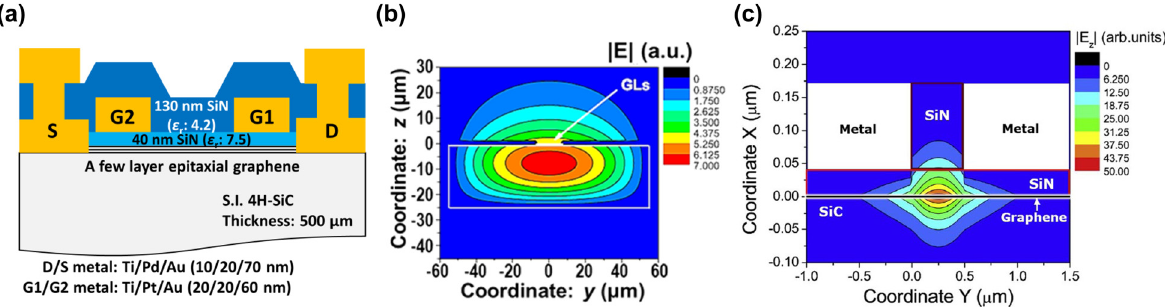
Figure 2: Numerically simulated THz in-plane ( y -axial component) fi eld distributions in DFB-DG-GFETs with photonic versus plasmonic cavities. (a) Device cross-sectional structure. (b) Cross-sectional contour map of the simulated THz photon field distribution of in-plane electric field